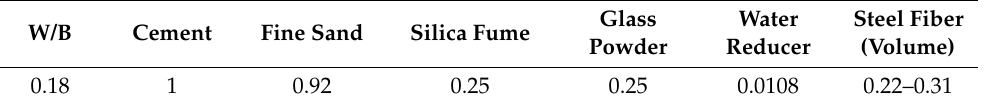
Table 1. An ultra-high-performance concrete (UHPC) mix design example by